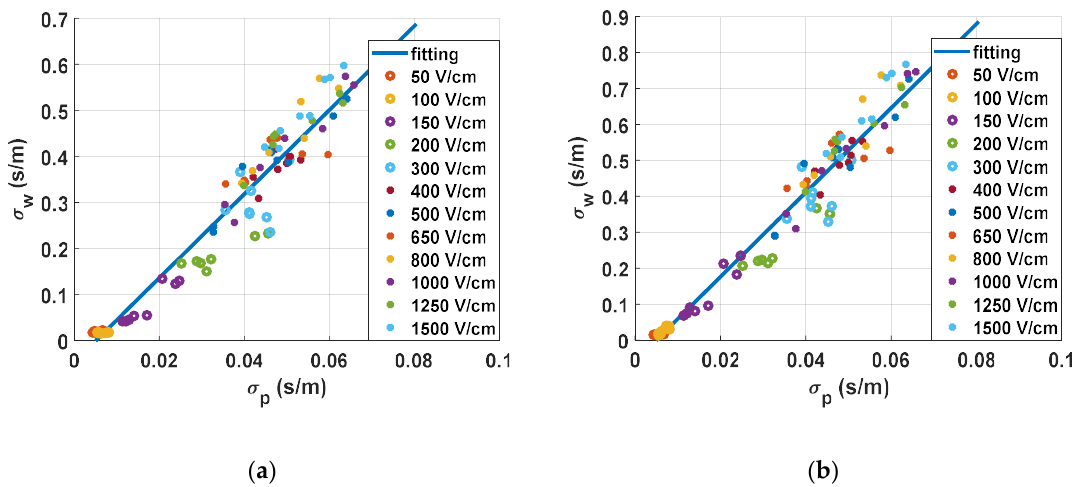
Figure 9. Correlation between the electrical conductivity measured in real time and the electrical conductivity measured in the distilled water after 1.5 h: ( a ) correlation of small-signal conductivity and ( b ) correlation of large-signal conductivity.